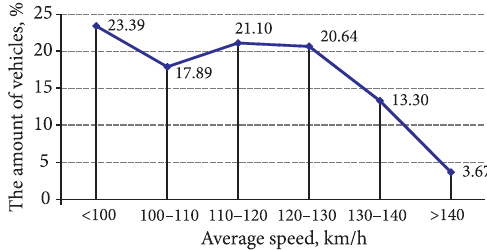
Fig. 3. Percentage distribution of vehicles on the road A2 by an average